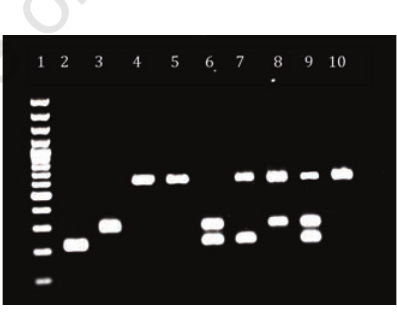
Figure 1. PCR (uni, duplex and triplex) of V. cholerae O1. Lane 1(Ladder 100bp),